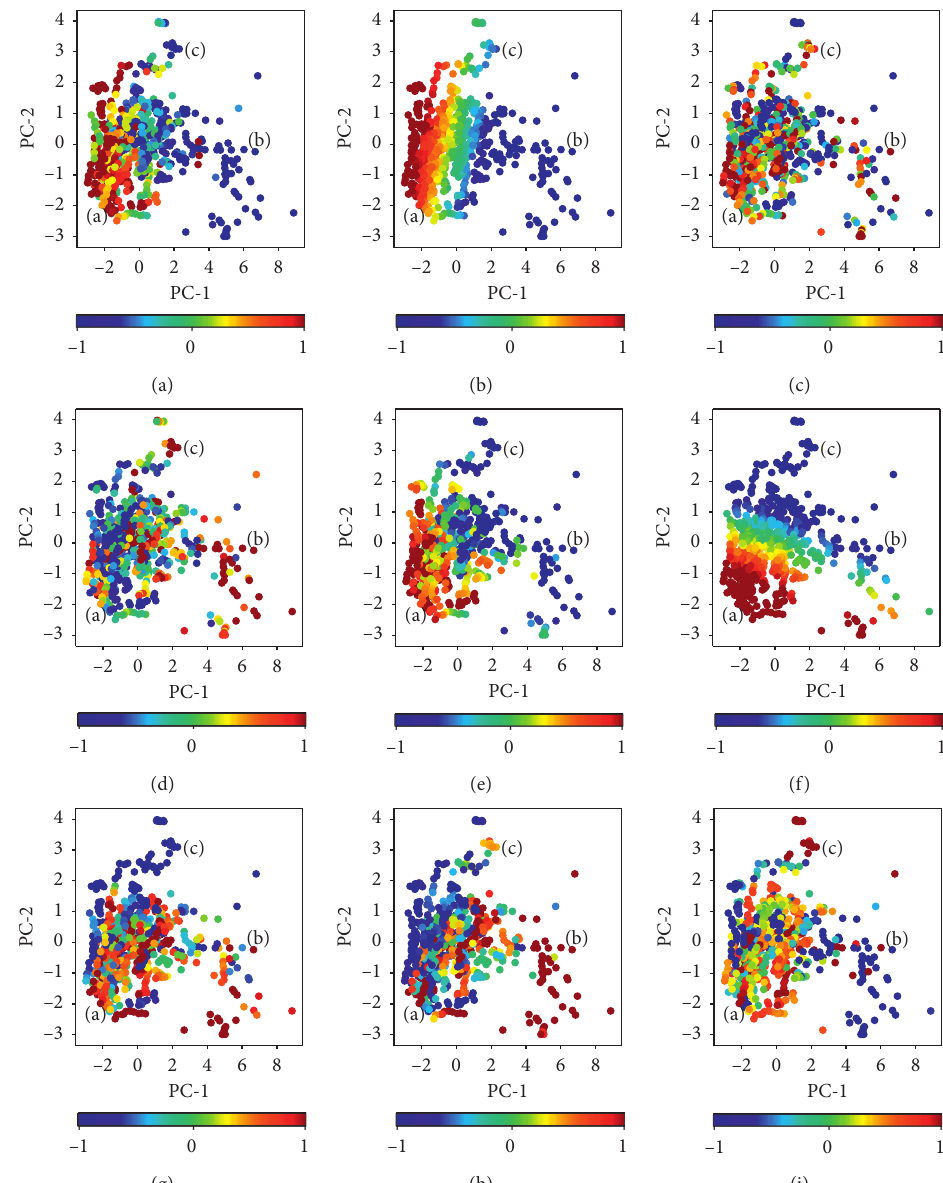
Figure 12: Principal component analysis (PCA) of enterprises based on functional and social communication monthly network features including the corresponding efficacy score. Dots represent individual companies at particular months. Their location in the scatter plots shows the dot product of the company’s feature vector and the corresponding component (PC-1 in the x -axis and PC-2 in the y -axis). Panels are colored by different features (see titles). Features have been normalized by subtracting the average and dividing by the standard deviation (scale on figure). The number of functional and social communications is in the logarithmic scale. Regions (A), (B), and (C) indicate the location of big, effective, and ineffective companies, respectively. More features are presented in Supplementary Materials (see Section S4). (a) Functional users. (b) Functional communications. (c) Functional clustering. (d) Functional density. (e) Social users. (f) Social communications. (g) Social clustering. (h) Social density. (i)